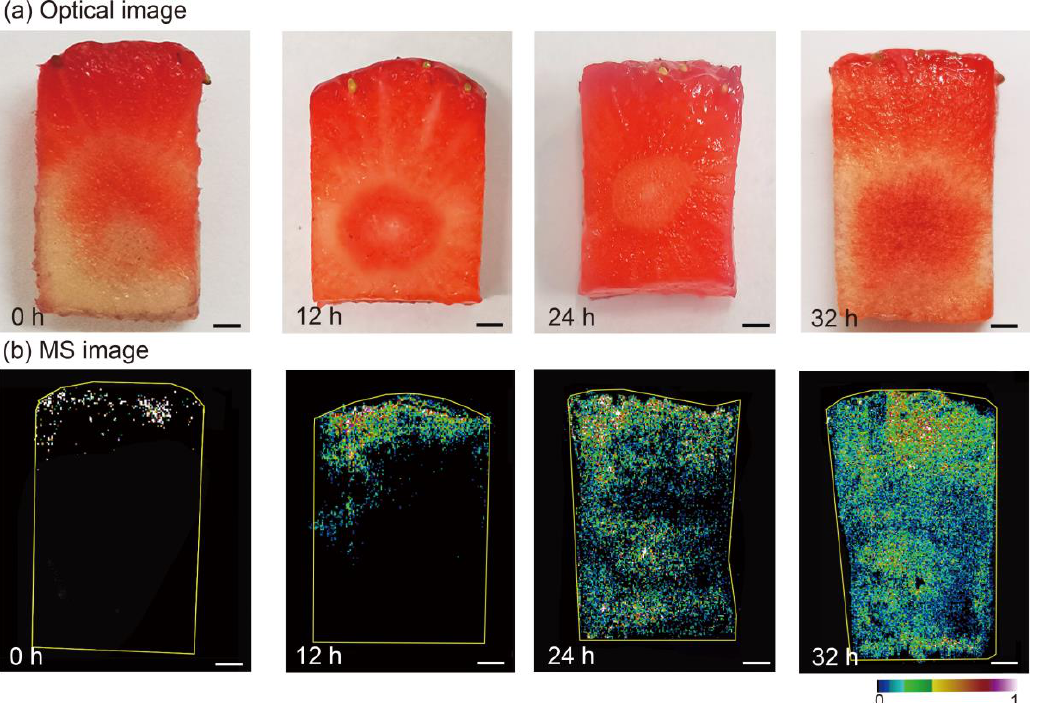
Figure 4. ( a ) Optical images and ( b ) the corresponding MS images of azoxystrobin in strawberry slices 0 h, 12 h, 24 h, and 32 h after being sprayed with azoxystrobin. Scale bar, 3 mm.